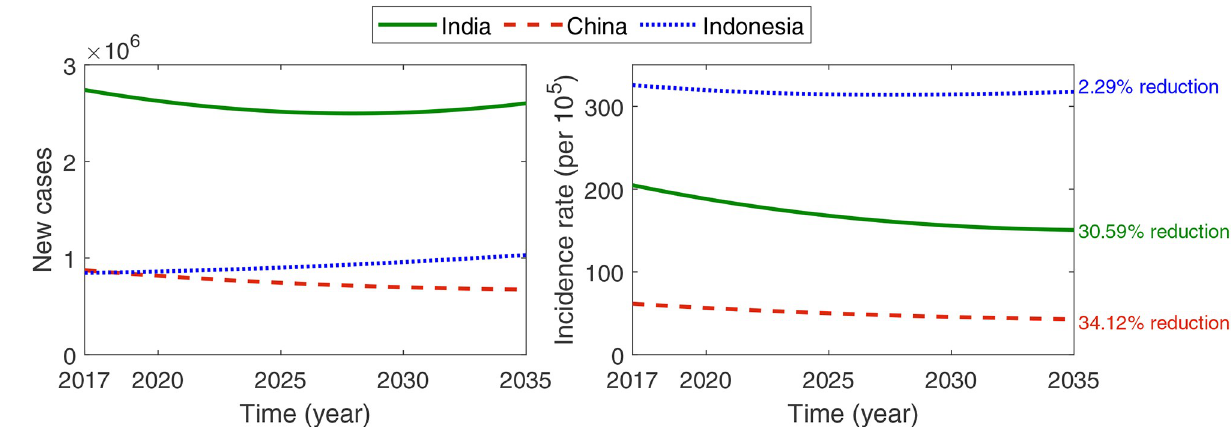
Fig 4. Expected number of incident cases (left) and incidence rate (right) from the TB model.